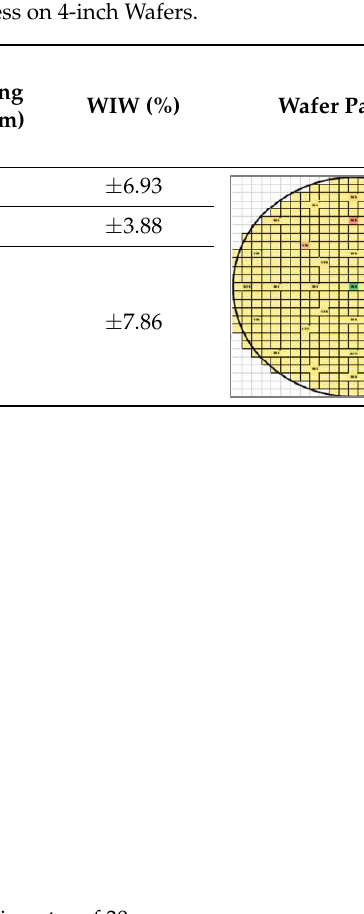
Table 7. Results of Deviation of Sn Plating Thickness on 4-inch Wafers.